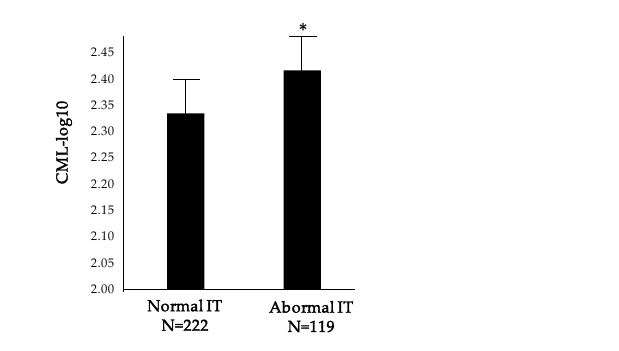
Figure 1. Comparison of baseline serum levels of N-epsilon-carboxy methyl lysine (CML; log- transformed) between patients with normal and abnormal implicit time (IT; IT (cid:3410) 37.43 milliseconds). * p = 0.009. AU: arbitray units